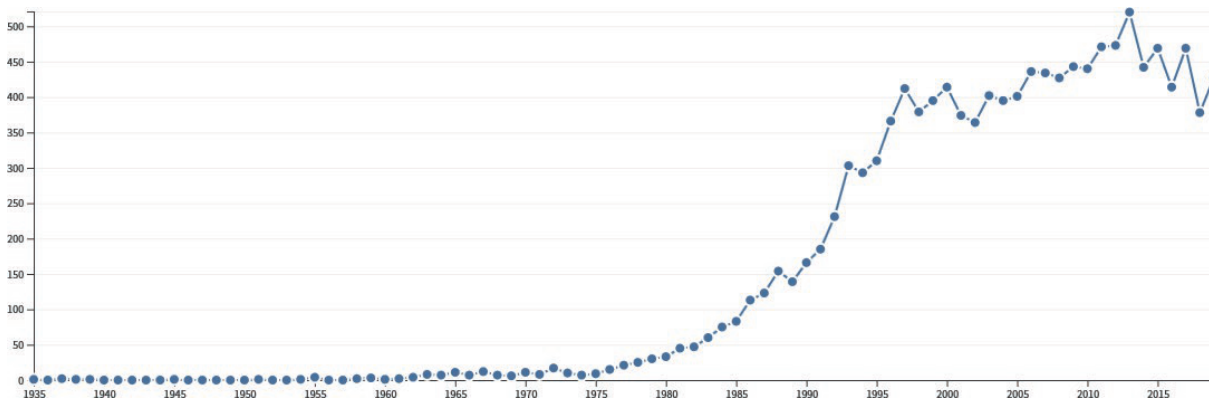
Figure 4. Number of citations per year 1935-2020 to the Møller-Plesset paper according to Web of